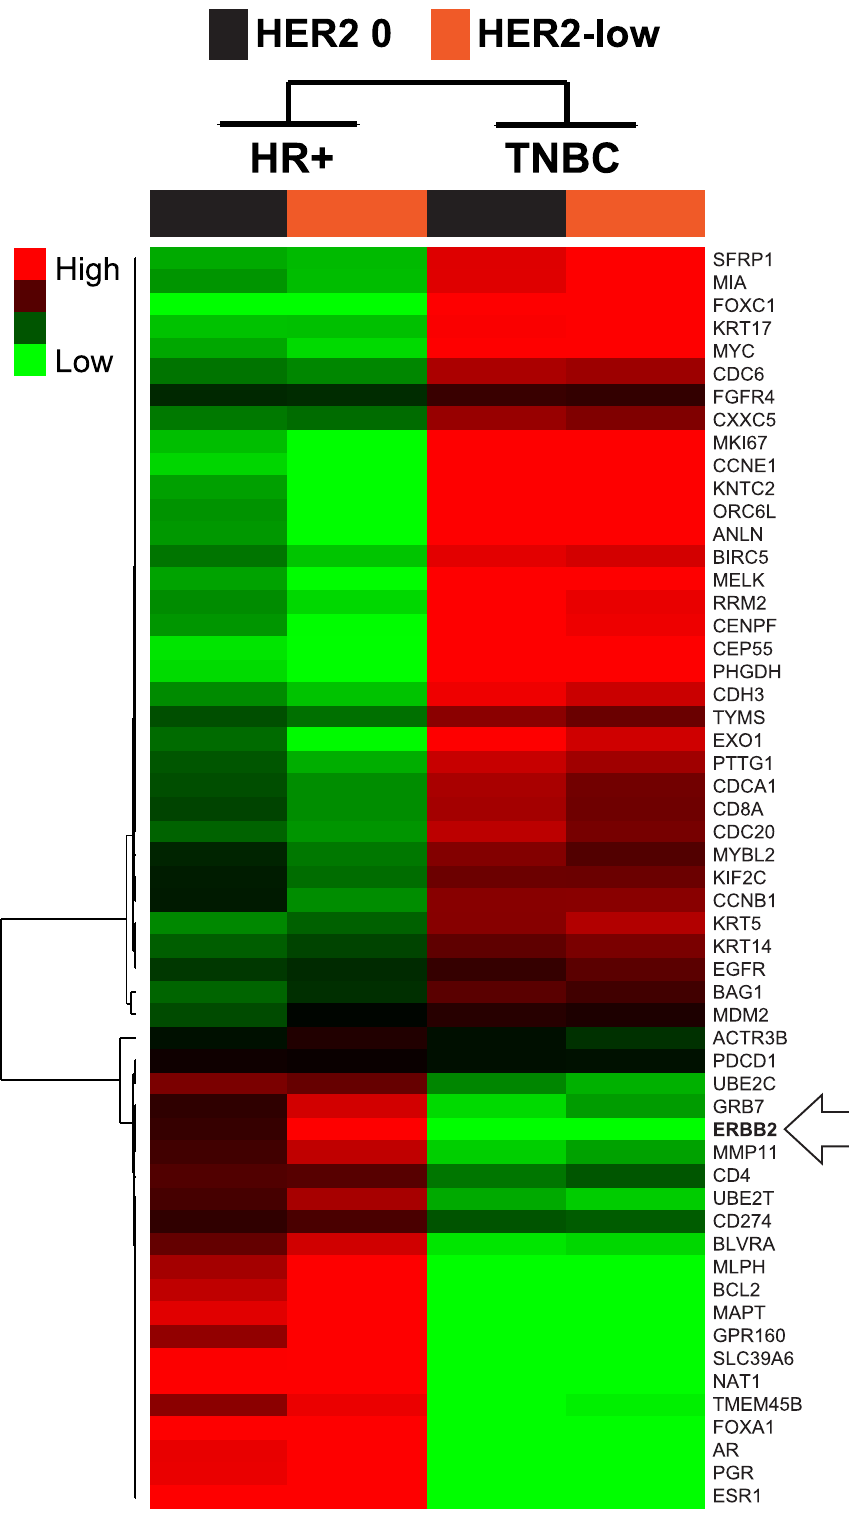
npj Breast Cancer (2021) 1 Published in partnership with the Breast Cancer Research